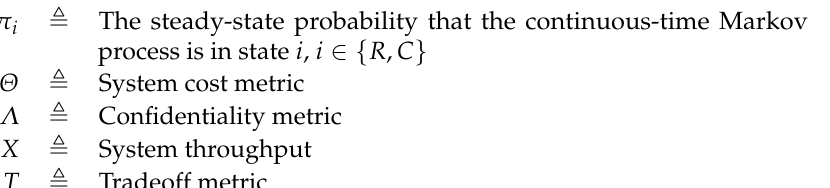
Table 1. Table of